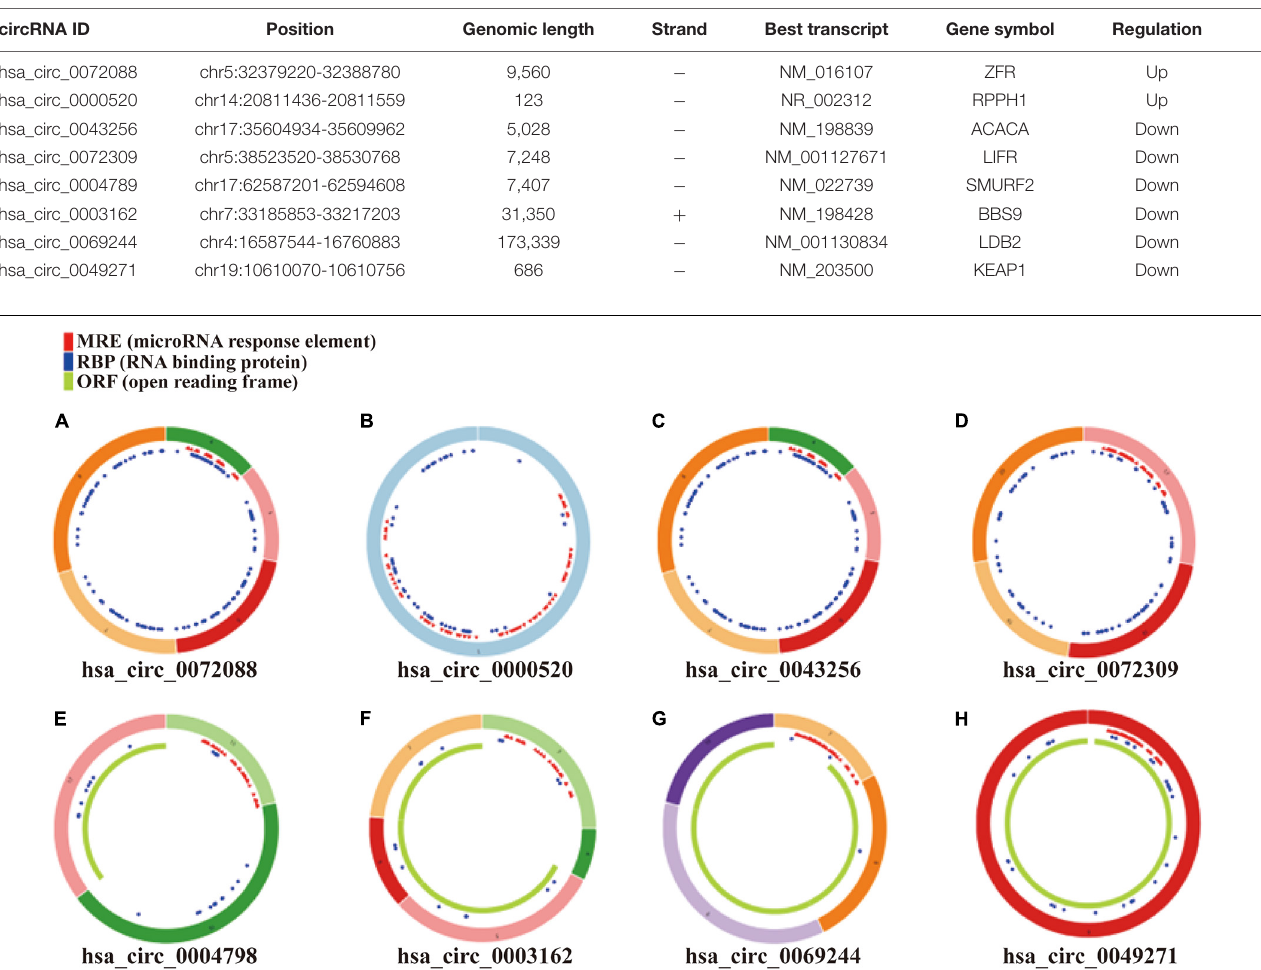
TABLE 2 | Basic characteristics of eight DEcircRNAs.